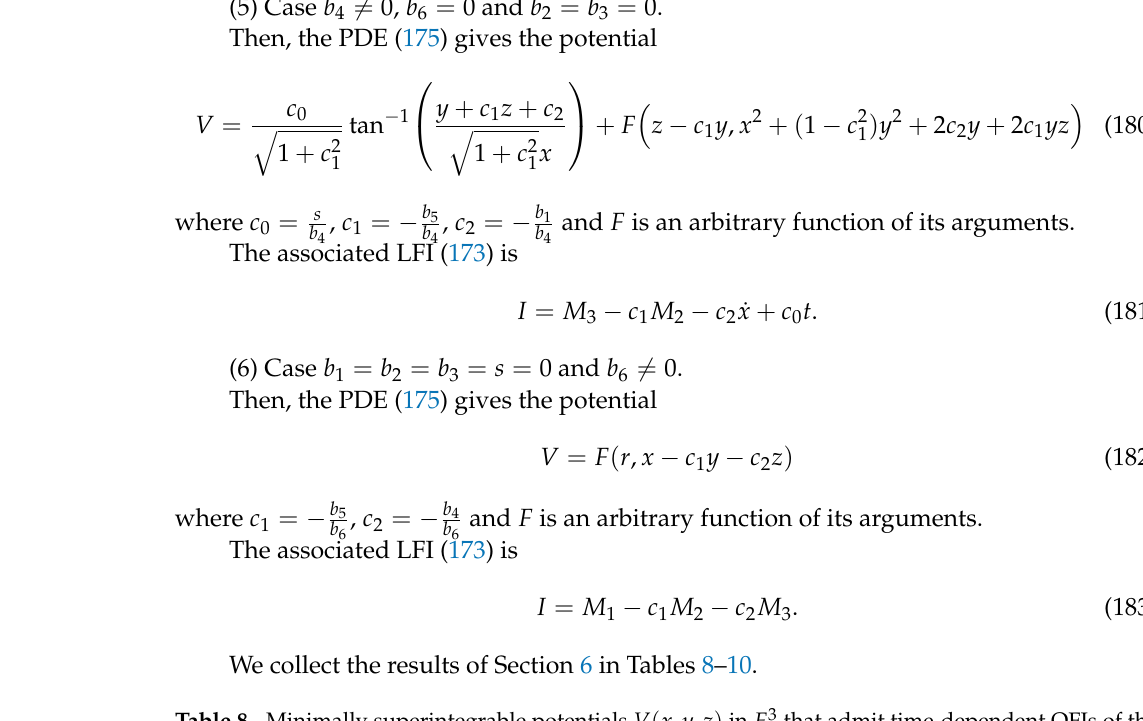
Table 8. Minimally superintegrable potentials V ( x , y , z ) in E 3 that admit time-dependent QFIs of the form I ( 2,0 )